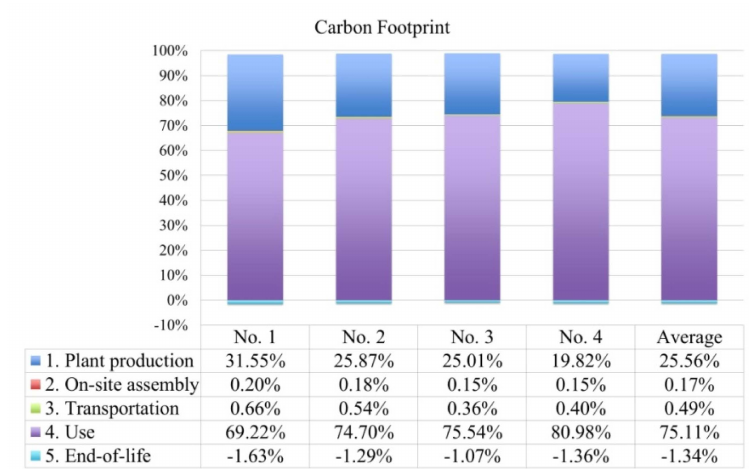
Figure 2. Contributions of the five life cycle assessment (LCA) phases to the carbon footprint of the four selected buildings.